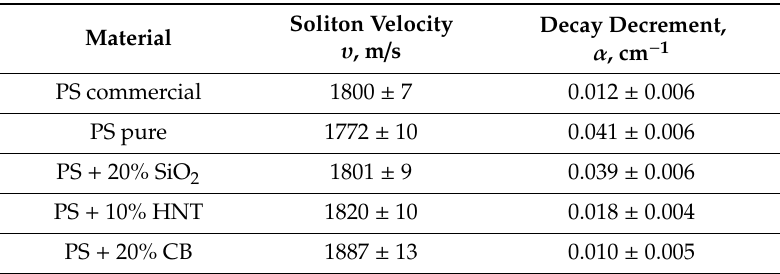
Table 5. Soliton velocities and decay decrements in